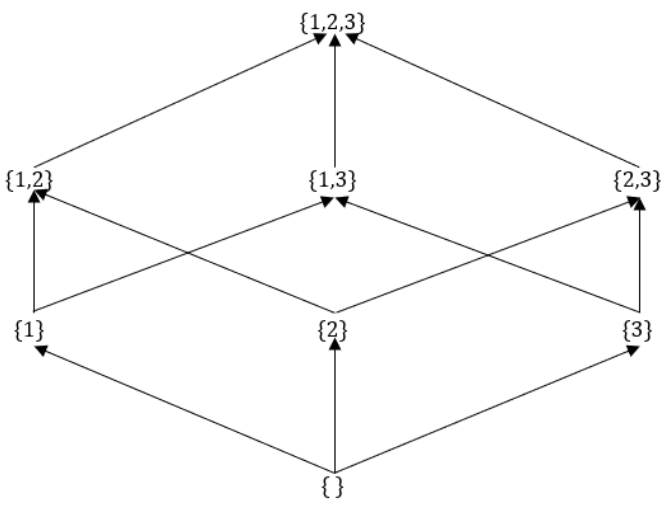
Figure 1. Chains in the power set of 3 elements.